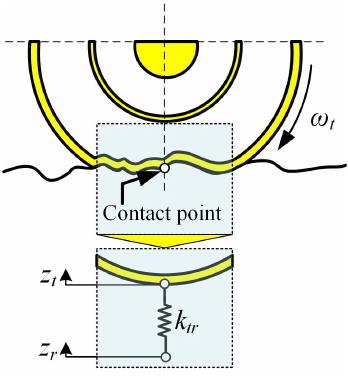
Figure 5. The equivalent process for